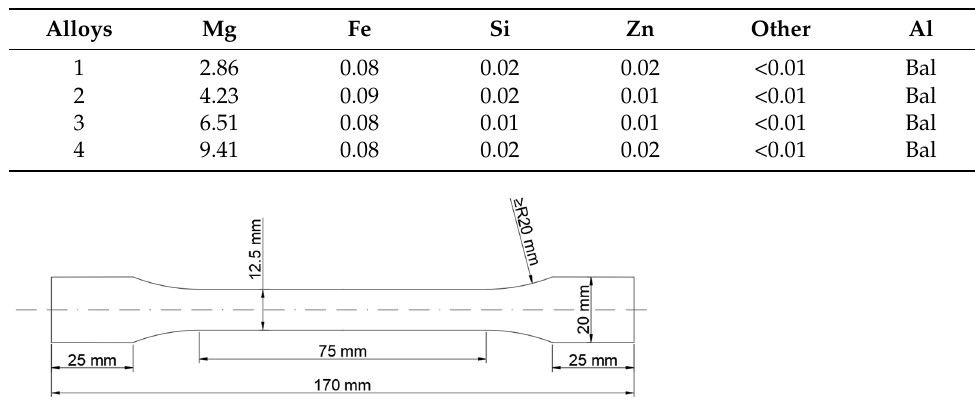
Table 1. Chemical compositions of the aluminum alloys used in this research (wt%).